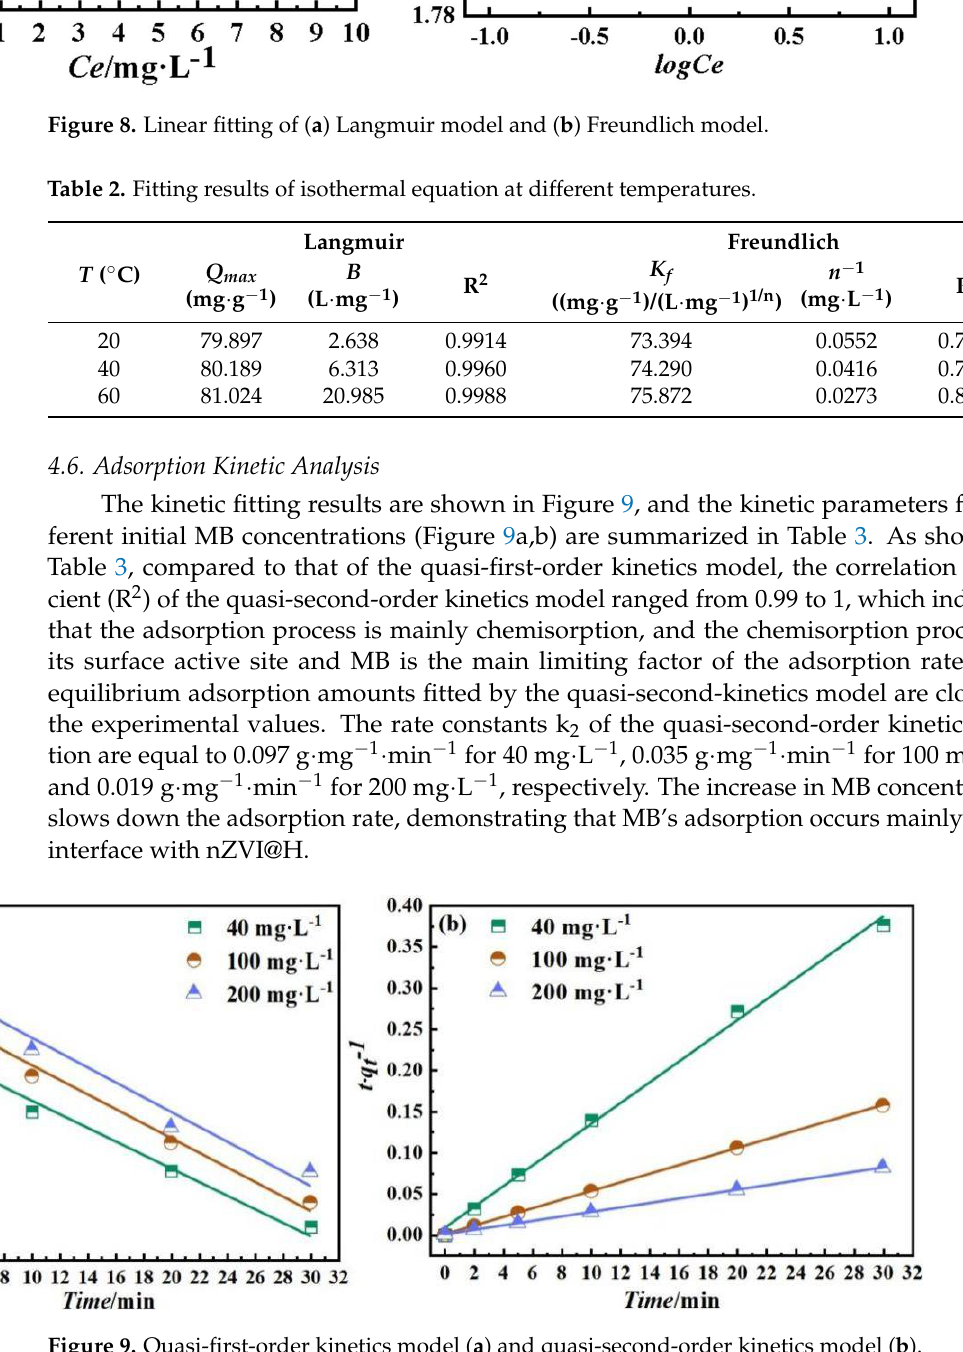
Figure 9. Quasi-first-order kinetics model ( a ) and quasi-second-order kinetics model ( b ). Table 3. Fitting results of kinetic equation under different concentrations.